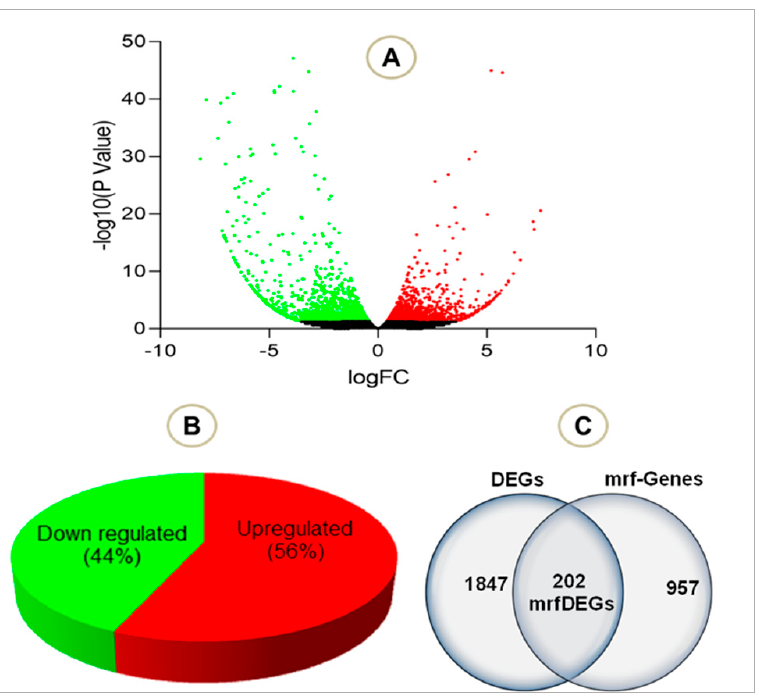
Figure 2. Total number of genes in the selected experiment ( A ) Volcano plot visualizing the differ- entially expressed genes (DEGs) in palmitic acid-treated human coronary artery endothelial cells (HCAECs). ( B ) Total number of downregulated and upregulated DEGs in percentage ( C ) Total DEGs, mitochondrial related functional genes and mrfDEGs. Green dot: downregulated genes, red dot: upregulated genes, black dot: not significantly regulated genes.